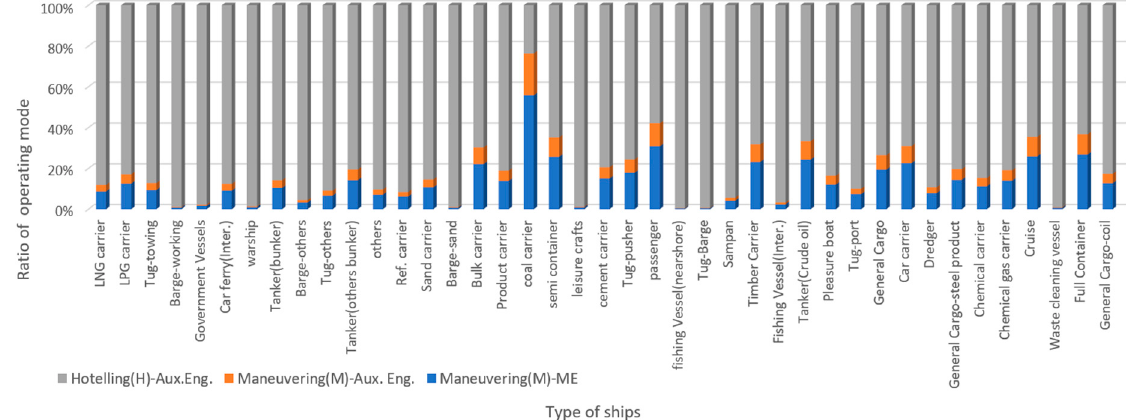
Figure 8. Comparison of fuel consumption by ship type and trips.